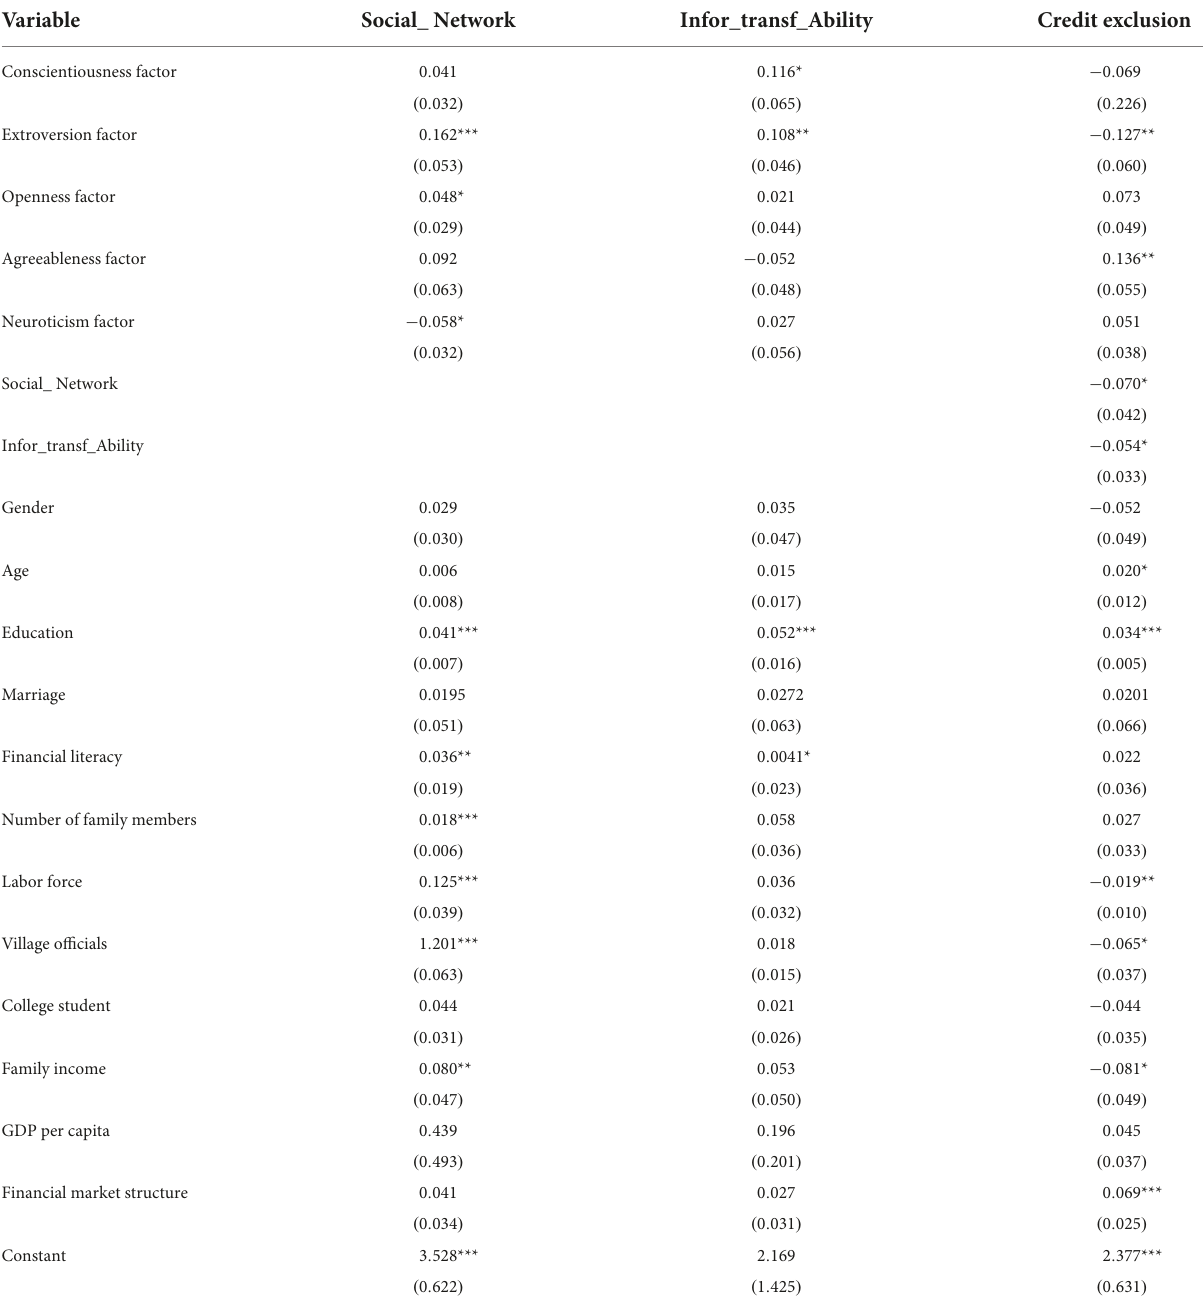
TABLE 9 Mechanism test regression results test regression